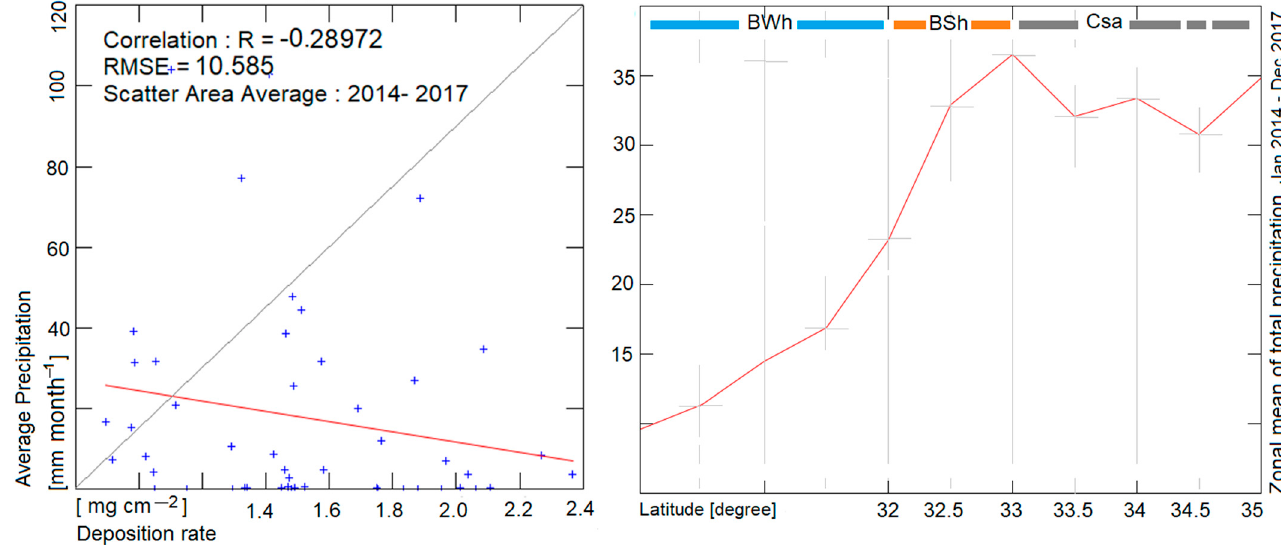
Figure 12. Correlation of the average monthly precipitation versus eolian deposition rate. Left : Correlation of precipitable 1. versus ground deposition rate (GDR) and Root Mean Square Error (RMSE) during the period 2014–2017. Right : Zonal means of total precipitation (mm month − 1 ) versus climate zones, which are represented in narrow bands at the top, wherein blue, orange, and gray denote BWh, BSh, and Csa, respectively).